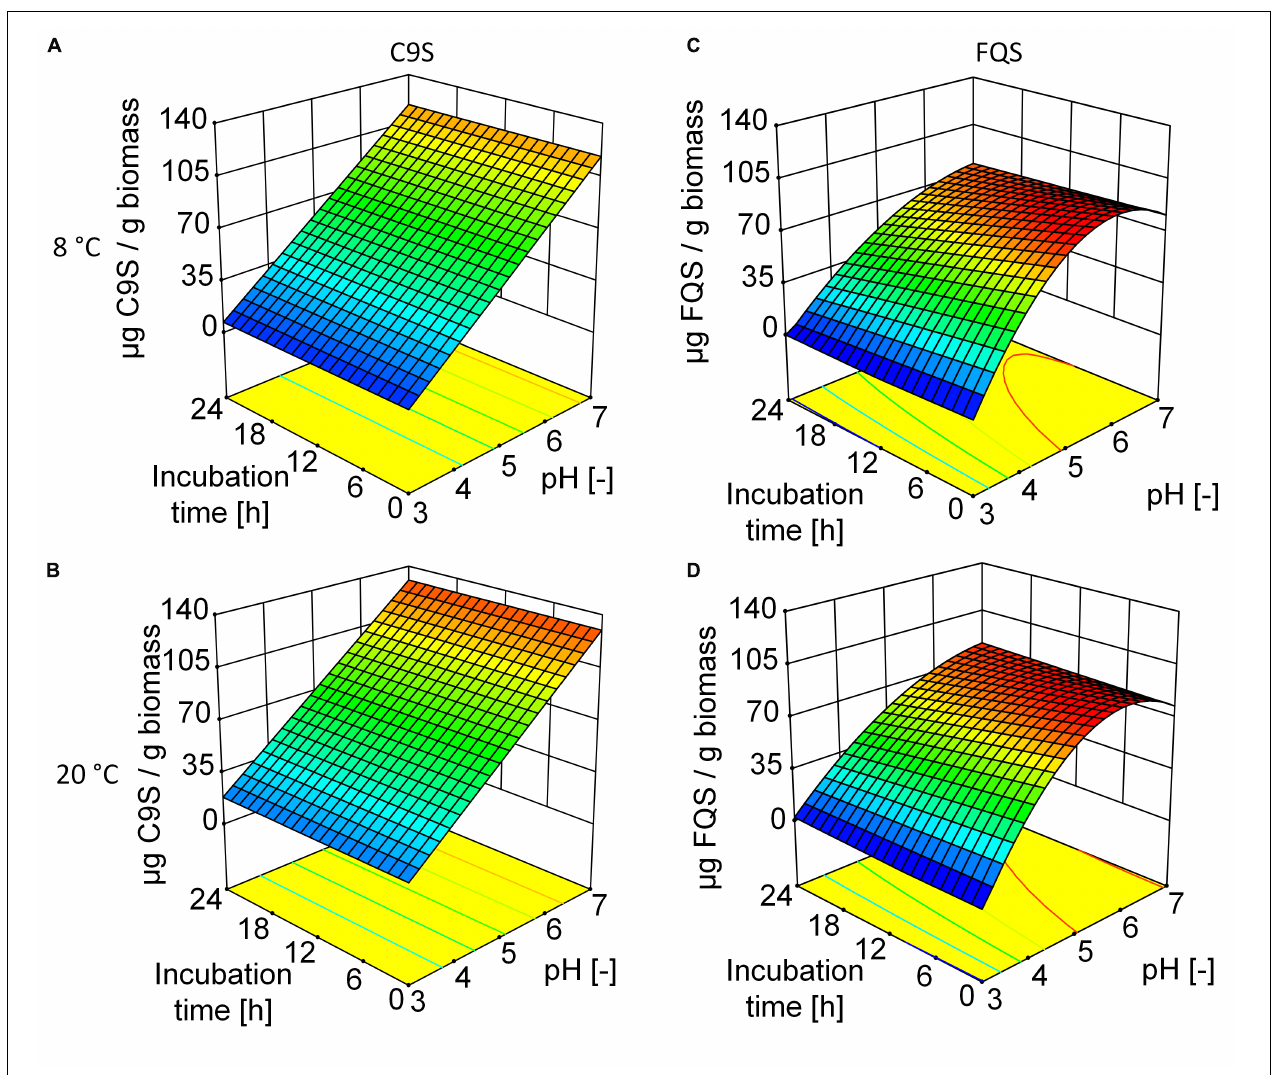
FIGURE 3 | Response surfaces models illustrating the effect of pH, storage time and temperature on the yield of C9S (A,B) and FQS (C,D). The yield of both target proteins decreased at lower pH values whereas incubation time and temperature had no relevant effect. At pH 5.0, the yield of FQS was higher than that of C9S. Colors are used to indicate high (red) or low (blue) response